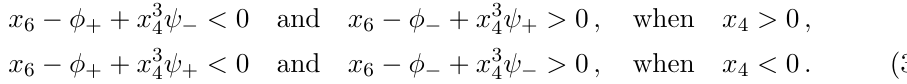
of the cubic term in (cid:27) is positive in the (+ ; (cid:0) ) phase and negative in the ( (cid:0) ; +)